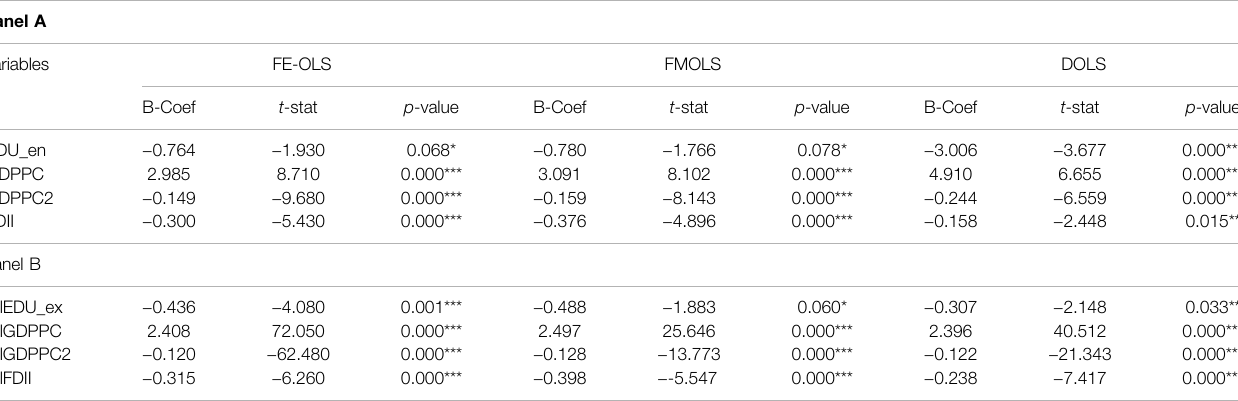
TABLE 6 | Long-run estimates for BRI